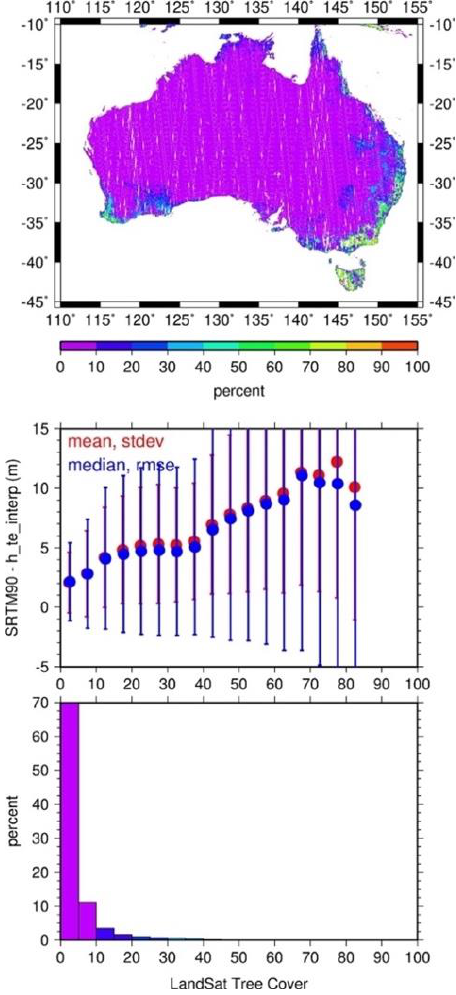
Figure 3. Differences between SRTM 90 m and ATL08 h_te_interp (in m) with respect to Landsat Percent Tree cover Continuous Fields for each 100 m segment. Percent Tree cover Mean, Median, Standard Deviations and RMSEs are shown for increments of 5% Tree cover.